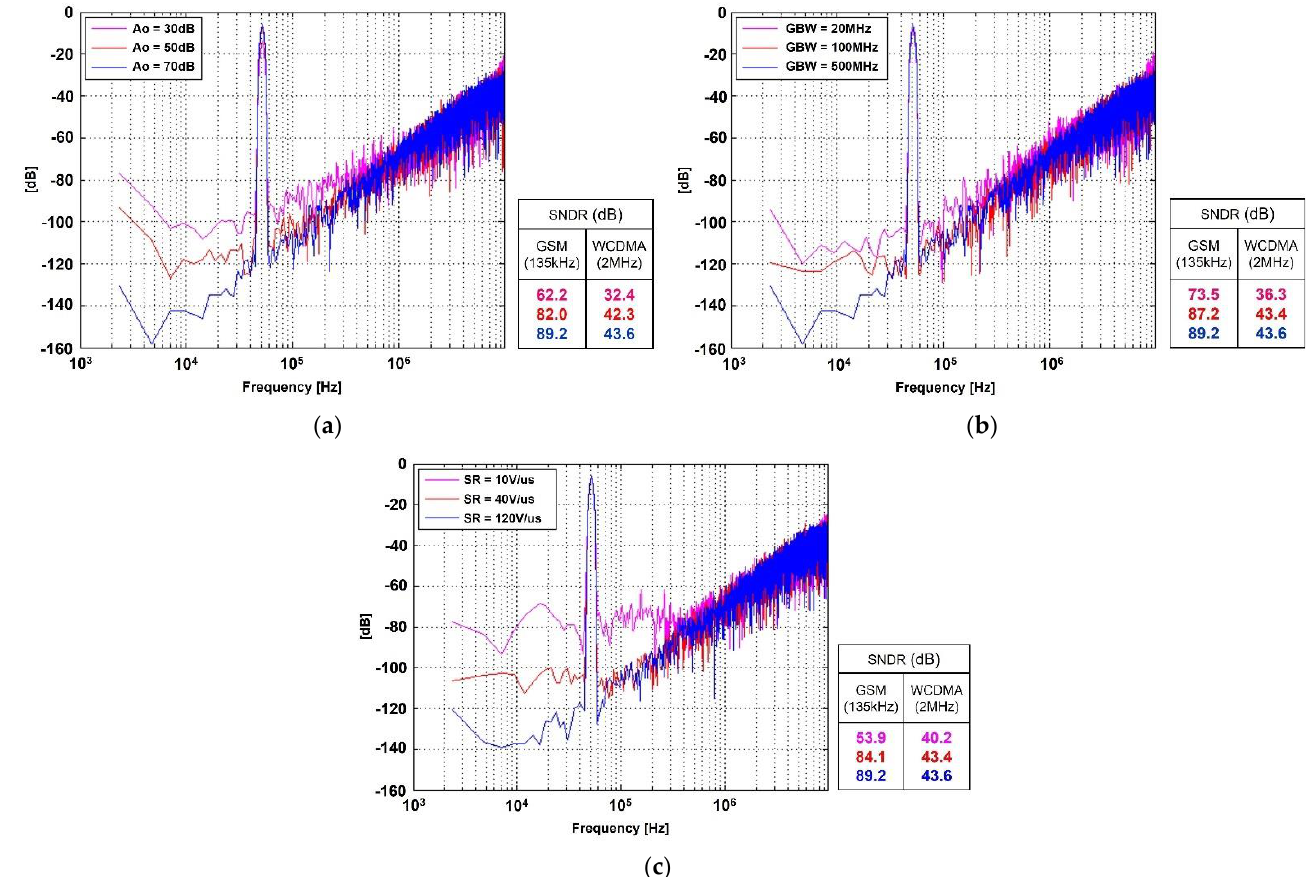
Figure 9. Modulator output spectrum with amplifier non-idealities. ( a ) A o , ( b ) GBW, and ( c ) SR.